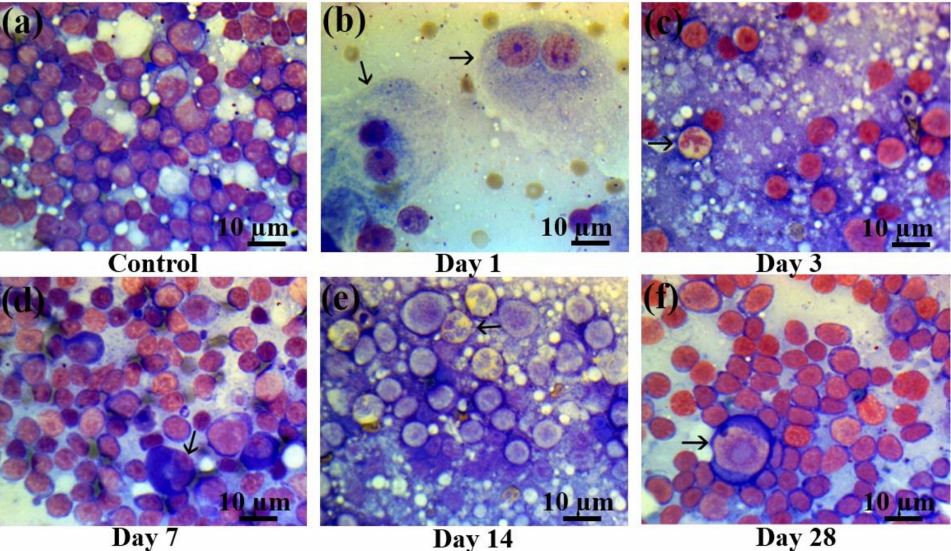
Figure 6. Lymph node smears in control rats and those exposed to the laser-driven UPEB irradiation. ( a ) Control lymph node smears; ( b ) 1st day after electron beam exposure: prominent lymphopenia arising from destroyed cells; pathological binuclear macrophages (arrowed); ( c ) 3rd day after electron beam exposure: increased amount of neutrophils (arrowed); lymphopenia; ( d ) 7th day after electron beam exposure: partial recovery of lymphocyte population; pathological neutrophil (arrowed); ( e ) 14th day after electron beam exposure: partial recovery of lymphocyte population; presence of pathological bilobed lymphoblasts (arrowed). ( f ) 28th day after electron beam exposure: partial recovery of lymphoid population; presence of proerythroblasts (arrowed). Lymph node smears were stained by Giemsa modified solution. Cells were examined under the light microscope at 1250 × magnification. Scale bar is 10 µ